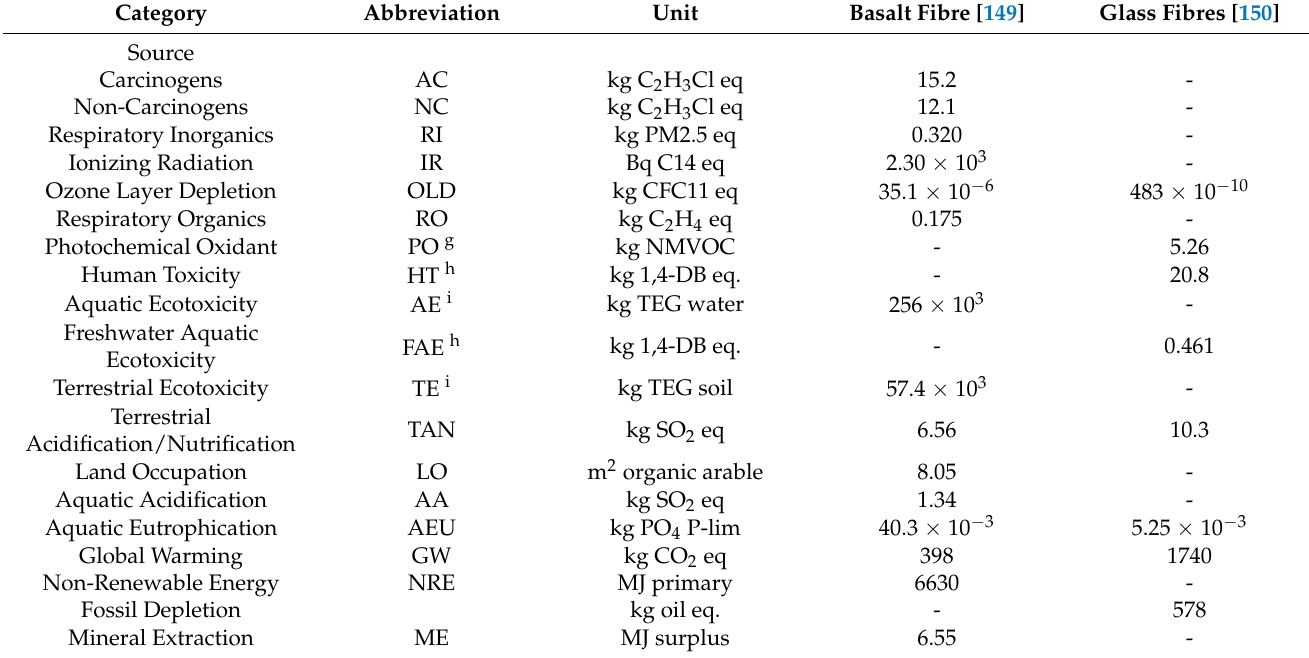
Table 6. Environmental externalities associated with production of 1 ton of basalt and glass fibre